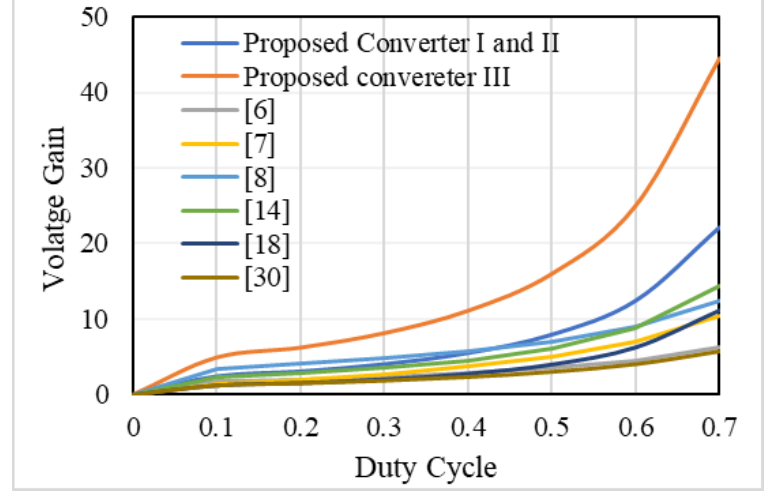
Figure 10. Voltage gain vs. duty cycle.